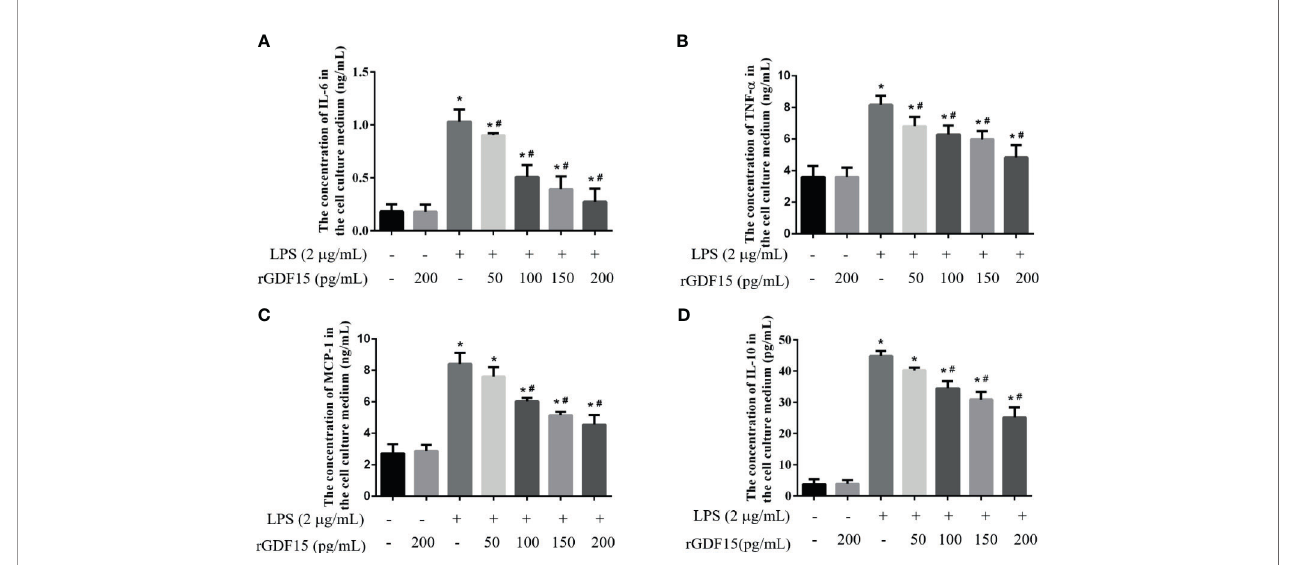
FIGURE 9 | The levels of IL-6 (A) , TNF- a (B) , MCP-1 (C) , and IL-10 (D) were changed after pretreatment with rGDF15 in in fl ammatory state of THP-1 cells. These cytokines were detected by fl ow cytometry. * P < 0.05, compare with the blank group; # P < 0.05, compare with the LPS